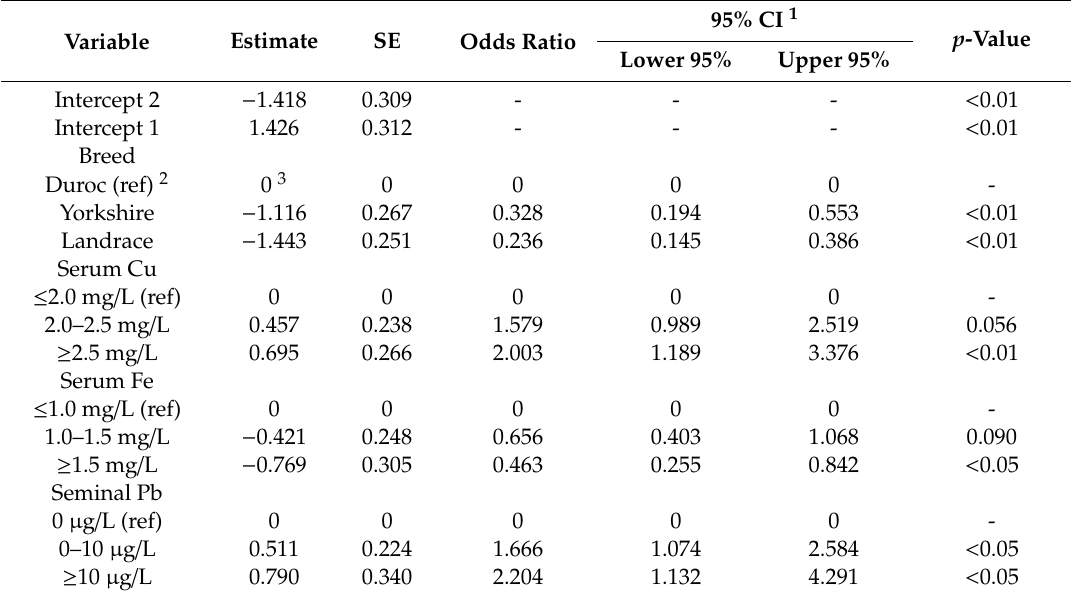
Table 7. The factors that influence the abnormal sperm morphology were extracted by forward selection in ordered logistic regression analysis (n =